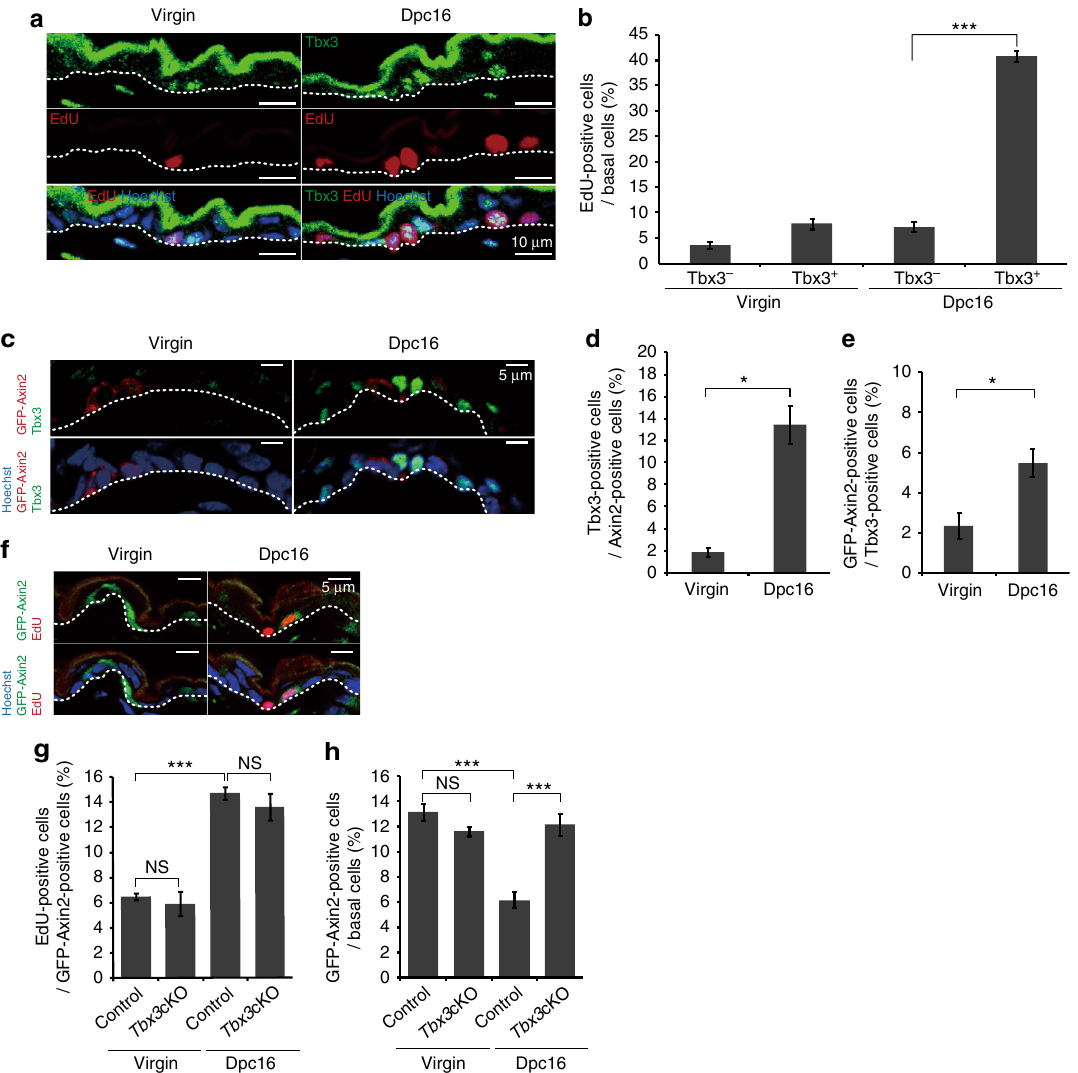
Fig. 3 Axin2 + IFE stem cells give rise to highly proliferative Tbx3 + basal cells during pregnancy. a Immuno fl uoresence of Tbx3 ( green ), EdU ( red ) and Hoechst ( blue ) on ventral skin from virgin and 16 dpc mice. b Quanti fi cation of EdU + cells in IFE basal layers. c Immuno fl uoresence of Tbx3 ( green ), GFP ( red ) and Hoechst ( blue ) on ventral skin from virgin and 16 dpc Axin2-d2EGFP mice. d , e Quanti fi cation of Tbx3 + cells in the GFP-Axin2 + cell population ( d ) and GFP-Axin2 + cells in the Tbx3 + cell population ( e ) in IFE basal layers. f Immuno fl uoresence of GFP ( green ), EdU ( red ) and Hoechst ( blue ) on ventral skin from virgin and 16 dpc Axin2-d2EGFP mice. g Quanti fi cation of EdU + cells in the GFP-Axin2 + cell population in IFE basal layers on ventral skin of virgin and 16 dpc Axin2-d2EGFP mice and Axin2-d2EGFP/Tbx3 cKO mice. h Quanti fi cation of GFP-Axin2 + cells in IFE basal layers. b , d , e , g , h Data represent the mean ± s.e.m. of averages of three independent experiments ( n = 3). > 500 cells ( b , h ), > 50 cells ( d , e ), > 450 cells ( g ) were analysed to calculate the average in each experiment; * P < 0.05, *** P < 0.001, analysed by the two-tailed t -test ( b , d , e ) or Tukey ’ s multiple comparison test ( g , h ). a , c , f White-dotted lines represent basement membranes. Experiments were repeated three times with three mice for representative two basal cells with symmetric or asymmetric expression of Tbx3 (Fig. 4g, h; patterns 3 and 4). In pattern 3, > 90% of the paired cells expressed CD71 in both daughter cells (Supplementary Fig. 3G; n = 21 from three mice), con fi rming that pattern 3 represents symmetric division of an Axin2-Cre-ER-labelled IFE basal cell that gives rise to a pair of Tbx3 + /CD71 + cells. As a second approach to investigate the cell division pattern during pregnancy, we labelled epidermal basal cells at clonal density by injecting pregnant K14-Cre-ERT2 27 /R26-H2B-GFP mice with a very low dose of tamoxifen (0.2 mg/25 g body weight). In the abdominal epidermis of virgin mice, where only a small fraction of IFE basal cells underwent cell division (see Fig. 1c), the majority of these cells had generated either two basal cells or one basal/one suprabasal cell without expressing Tbx3